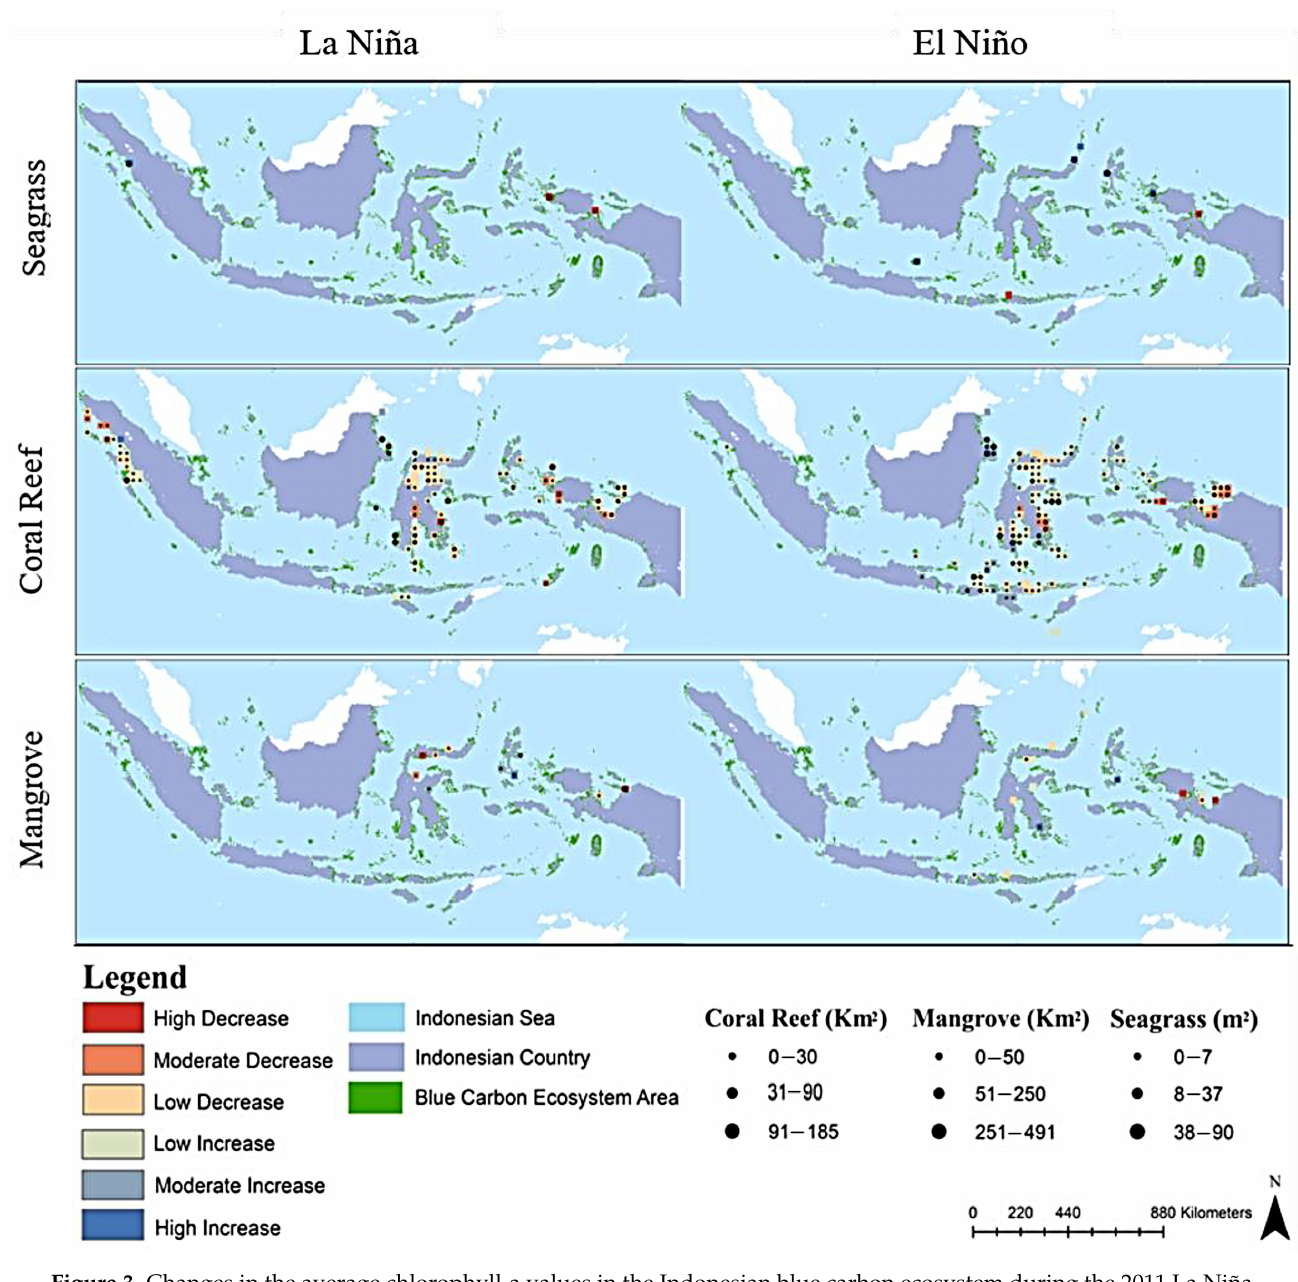
Figure 3. Changes in the average chlorophyll-a values in the Indonesian blue carbon ecosystem during the 2011 La Niña and 2015 El Niño